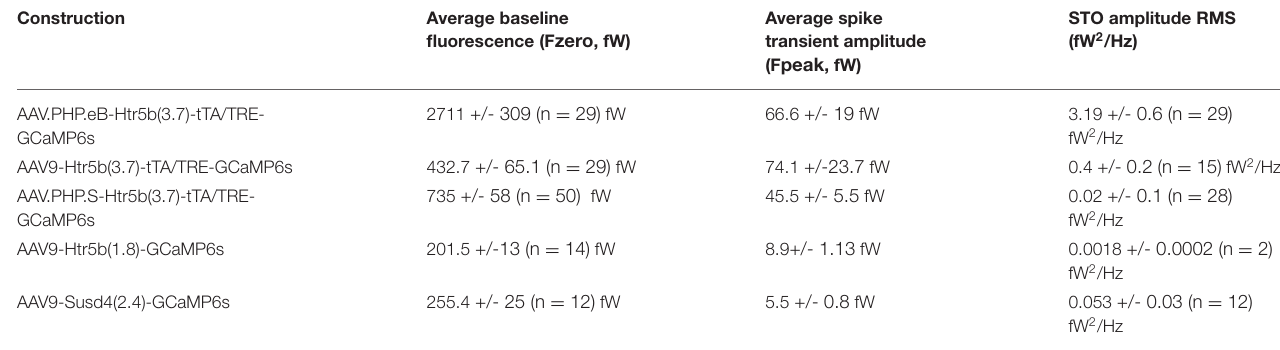
TABLE 3 | In-vitro properties of GCaMP6s signals found in inferior olive. Construction Average baseline fluorescence (F zero ,